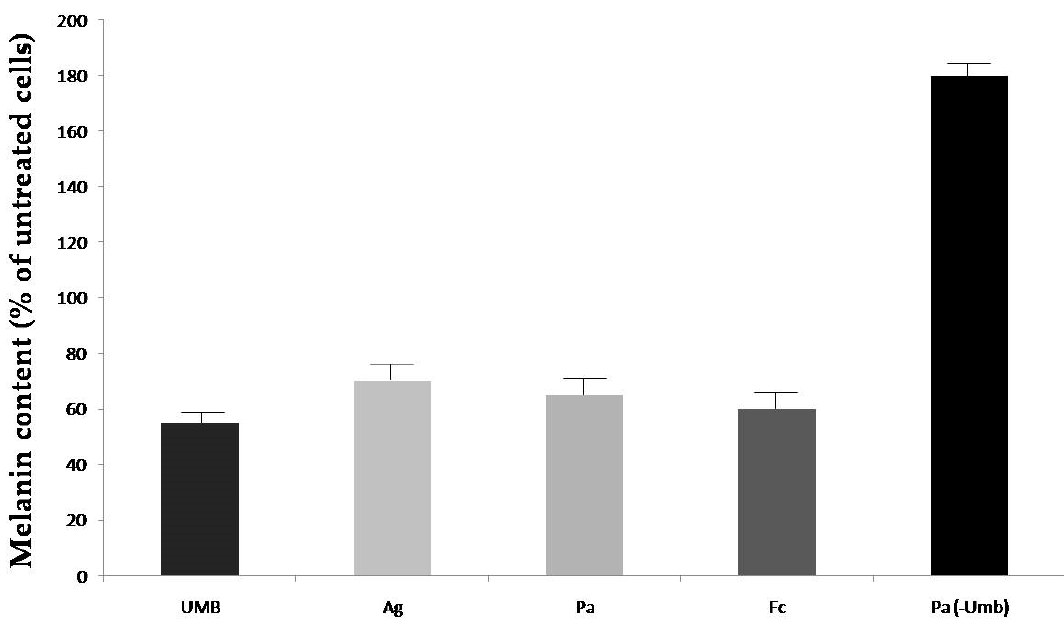
Figure 2. Effect of seeds extracts (100 µ g/mL) of A. graveolens , P. anisum, and F. campestris on melanin biosynthesis in Melan-A cells (Umb = Umbelliprenin 40 µ M, Ag = A. graveolens , Pa = P. anisum , Fc = F. campestris , Pa-Umb = extract from P. anisum with the lowest detected content in umbelliprenin, p < 0.05 at Student’s t -test).